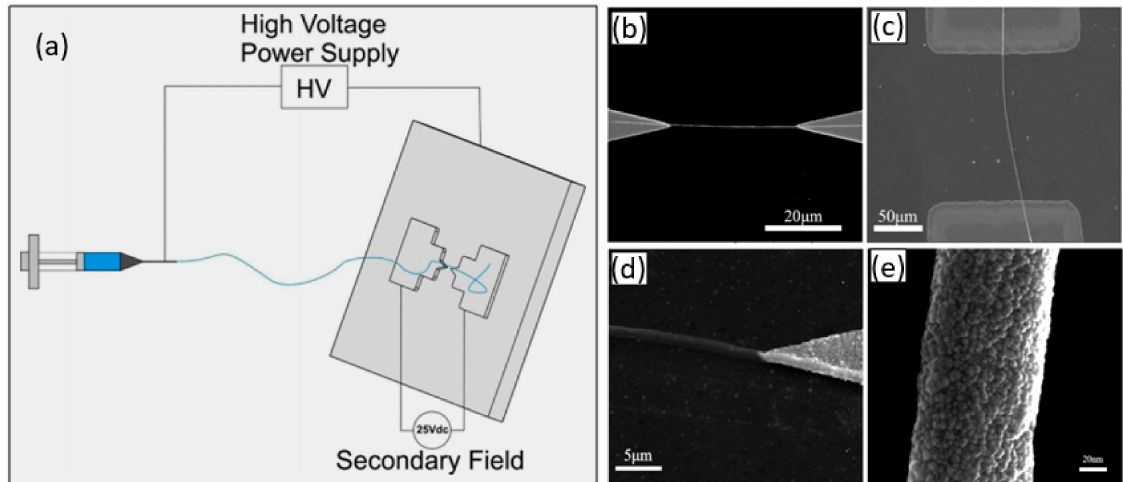
Figure 7. ( a ) Schematic representation of different fields during the electrospinning process. ( b – e ) FE-SEM images of ( b ) aligned pure single nanofiber on a triangular-type electrode, ( c ) aligned pure TiO 2 single nanofiber on a rectangular-type electrode, ( d ) aligned fiber (before thermal treatment) on the tip of a triangular electrode and ( e ) TEM image of a pure TiO 2 nanofiber. ( a ) Reprinted with permission from [86]. Copyrights 2017 ACS; ( b – e ) Adapted with permission from [141]. Copyright 2015